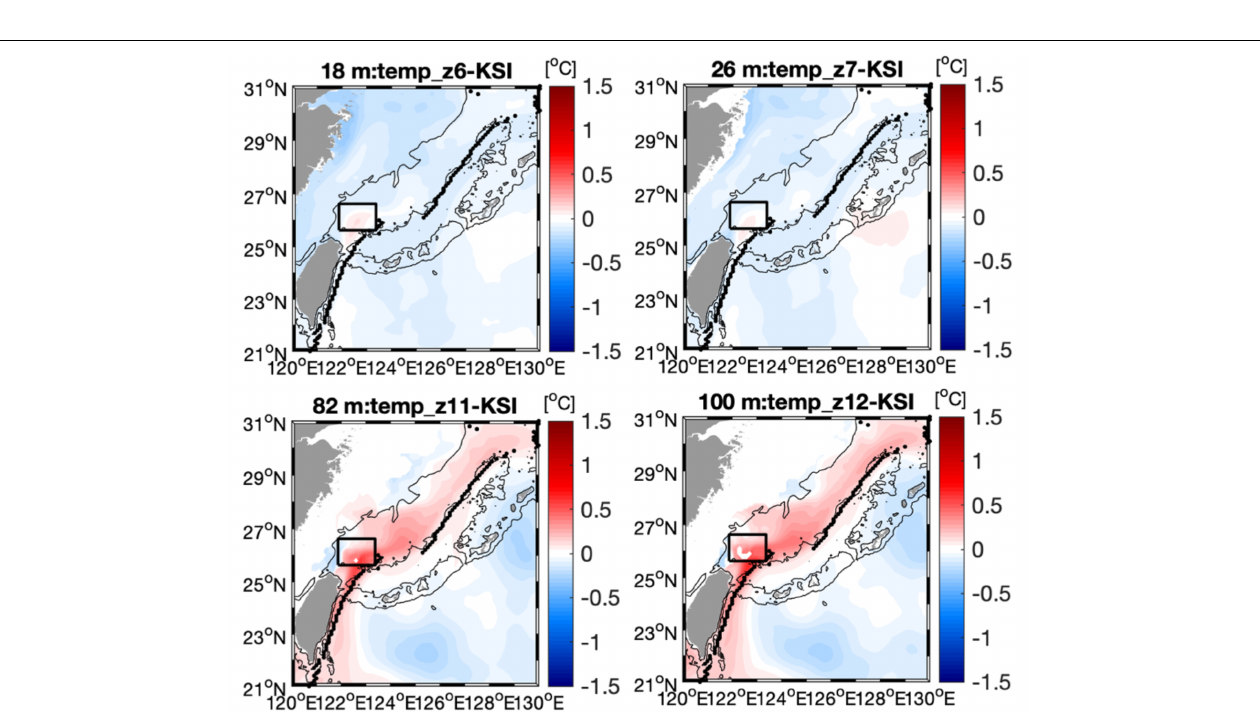
FIGURE 6 | Regressed subsurface temperature anomalies at 18, 26, 82, 100 m targeting the KSI strength mode from FORA. The mean path of the Kuroshio is displayed as black dots. Black squares denote the KSI domain, and black contours denote 100 and 1,000 m isobaths.